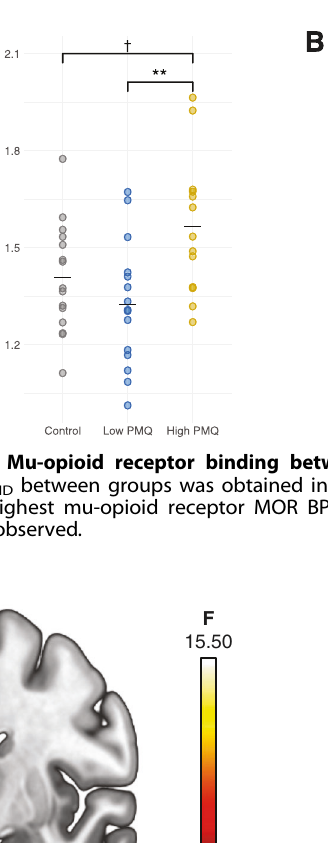
Fig. 3 Whole-brain group differences in Mu-opioid receptor binding potential. Signi fi cant differences ( p FWE < 0.05) in baseline MOR BP ND between groups was observed in the left extended amygdala, with individuals in the low-risk for opioid misuse group (PMQ-L) exhibiting lower mu-opioid receptor availability relative to PMQ-H and Control